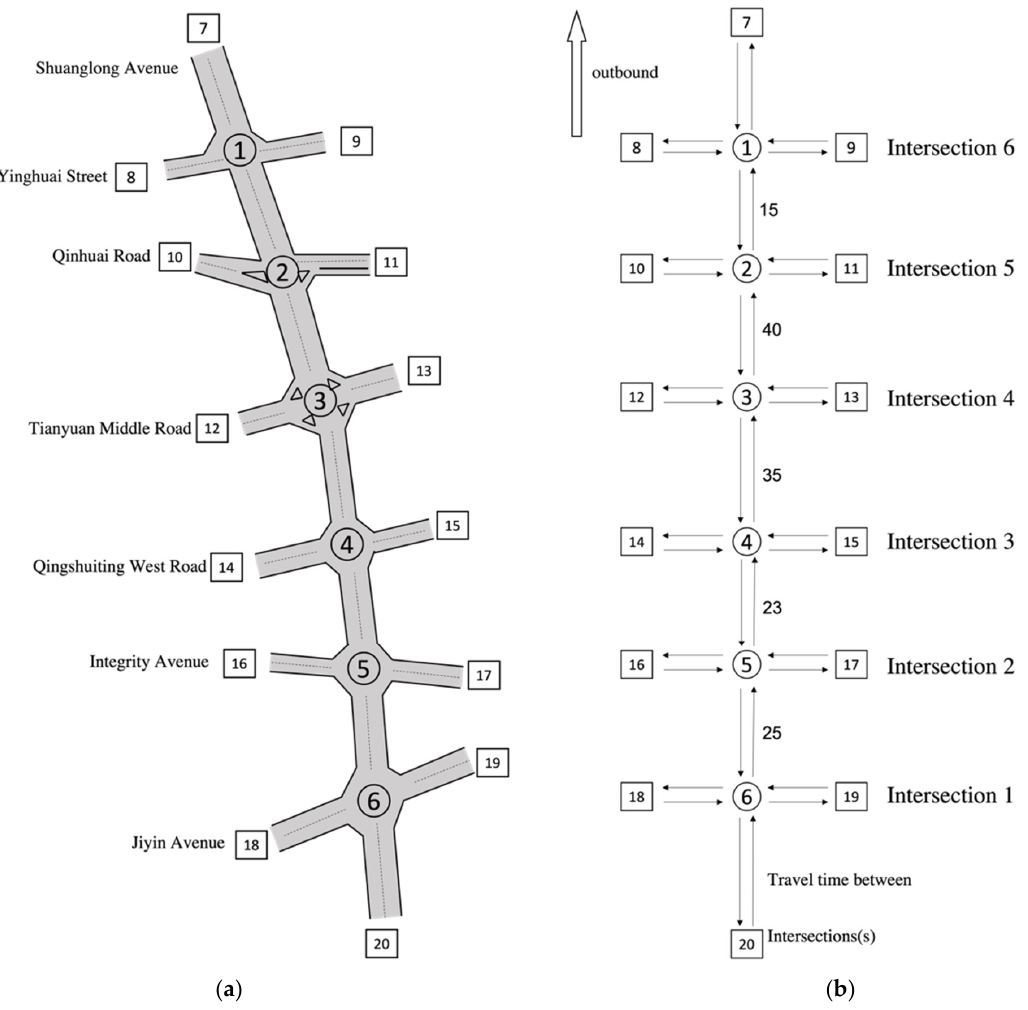
Figure 8. Intersections and travel time distribution.: ( a ) Distribution of experimental intersections; ( b ) intersection travel time distribution.